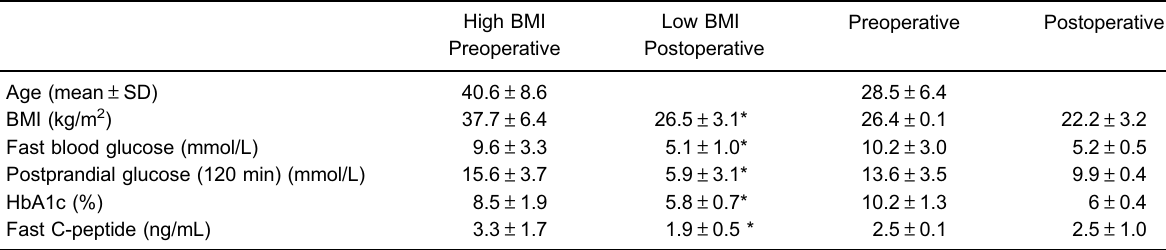
Table 2. Clinical follow-up